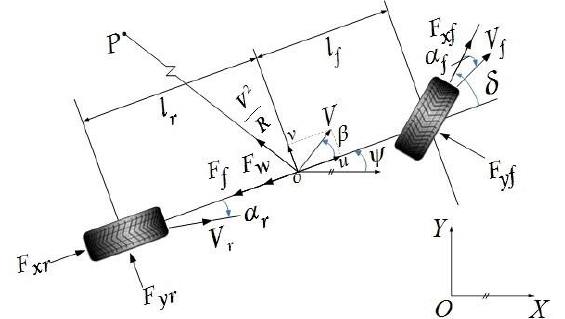
Figure 1. 3-DOF single-track model.